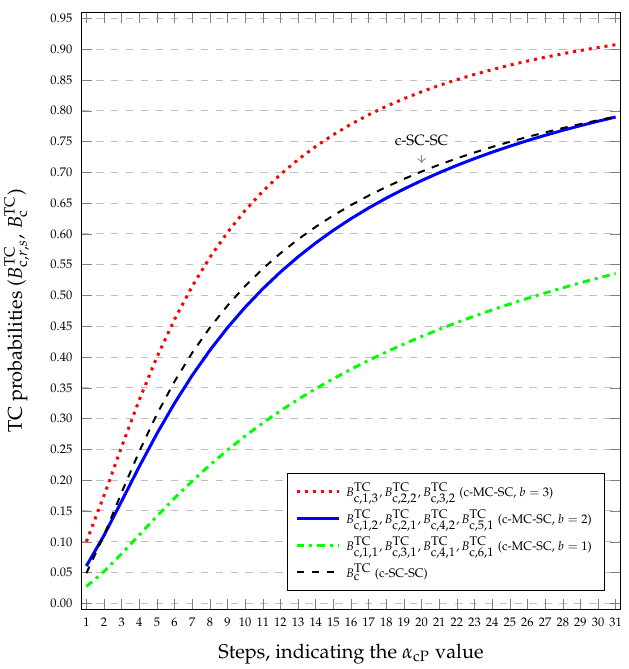
Figure 3. TC probabilities, B TC c, r , s , for all services-classes in all RRH (c-MC-SC vs.